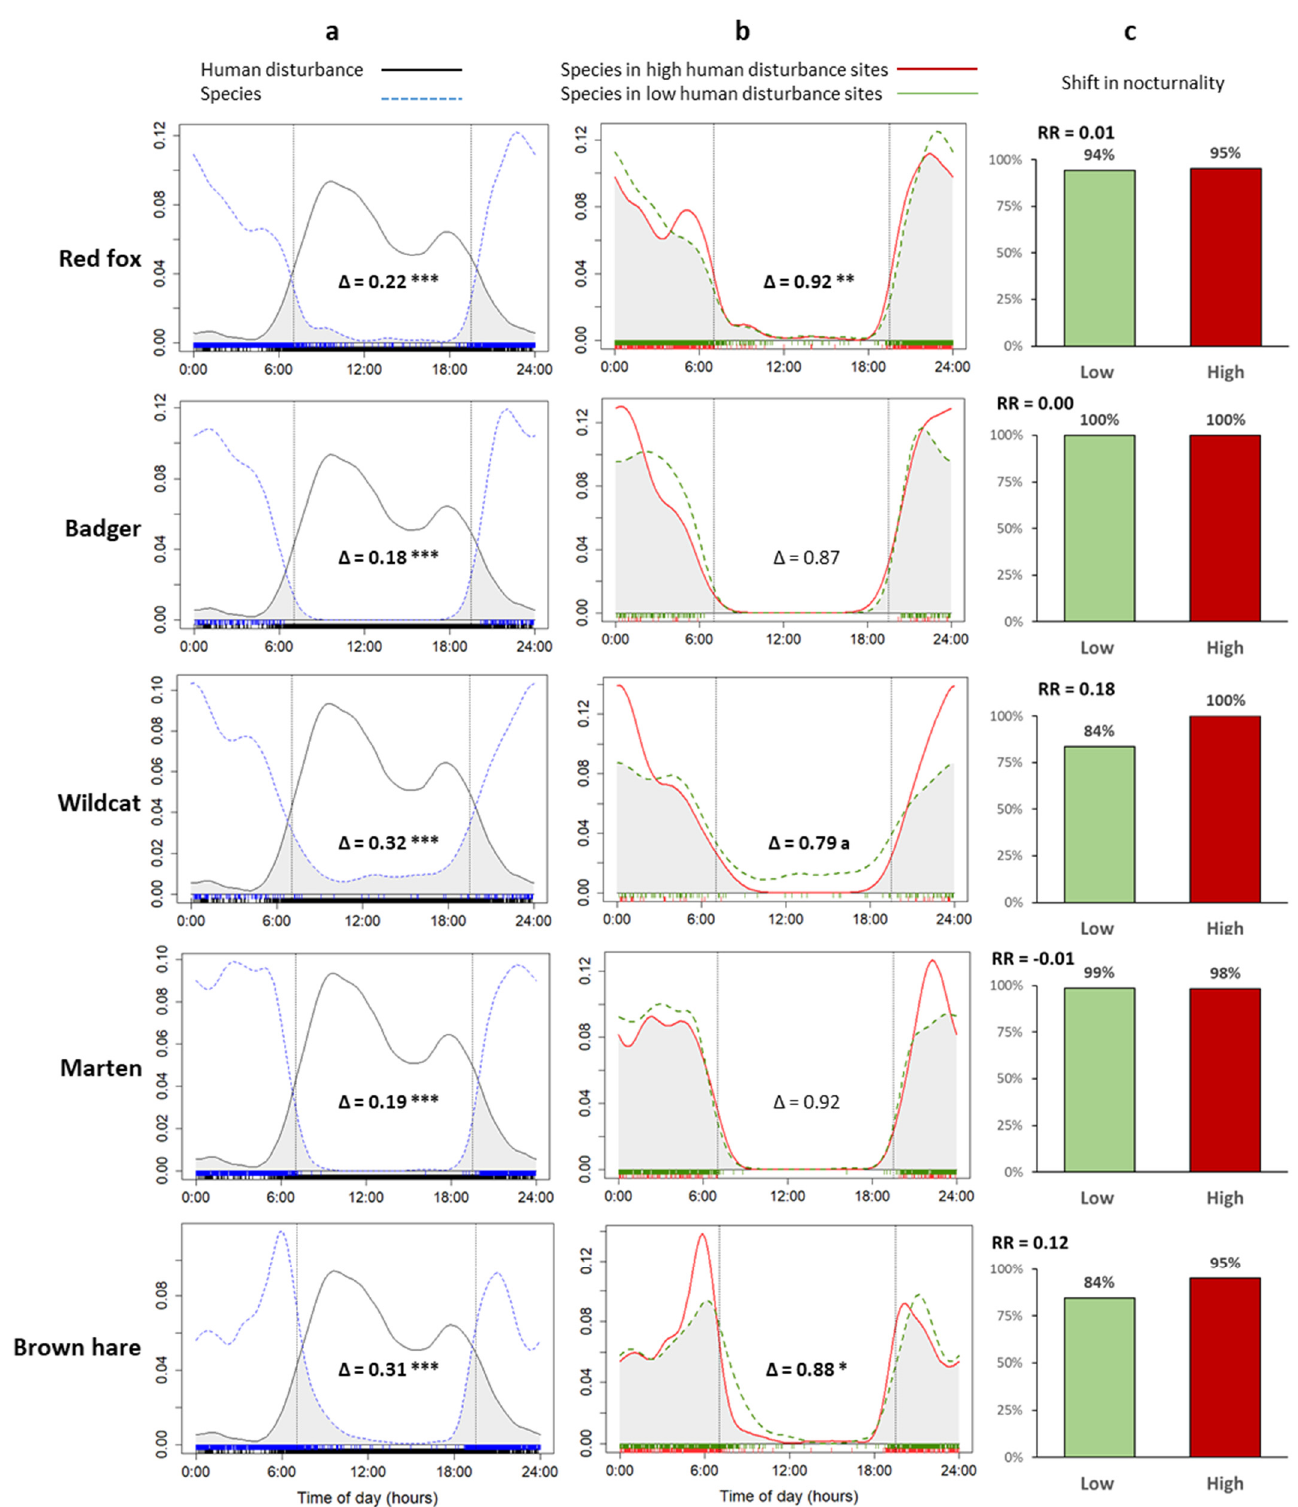
Figure 3. ( a ) Overlap in temporal activity between wild mammals and human disturbance in Greece, 2019 – 2020. ( b ) Wild mammal temporal activity overlap between low and high human disturbance sites. Vertical dashed lines represent the average sunrise (07:04) and sunset (19:32) times. Significant and marginally significant differences in overlap resulting from the MWW test are shown in bold (***: p < 0.001, **: p < 0.01, *: p < 0.05, a: 0.1 < p < 0.05) ( c ) Nocturnality (percentage of nighttime detections) and shift of nocturnality (RR: risk ratio) between low and high human disturbance